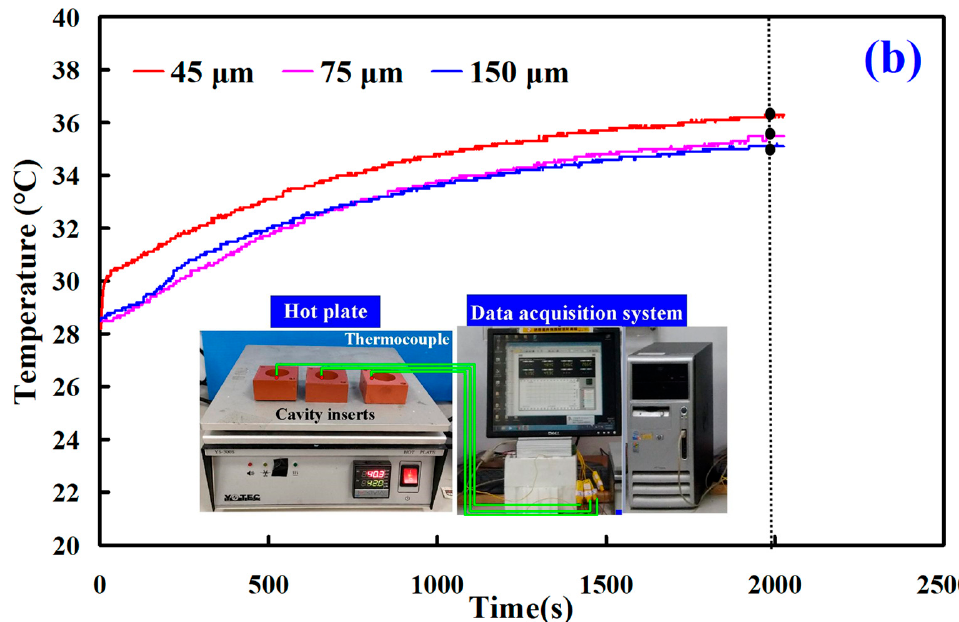
Figure 10. Results of the heat conduction experiment for ( a ) core and ( b ) cavity of the wax injection mold fabricated by epoxy resin filled with three different particle sizes of Cu powder.